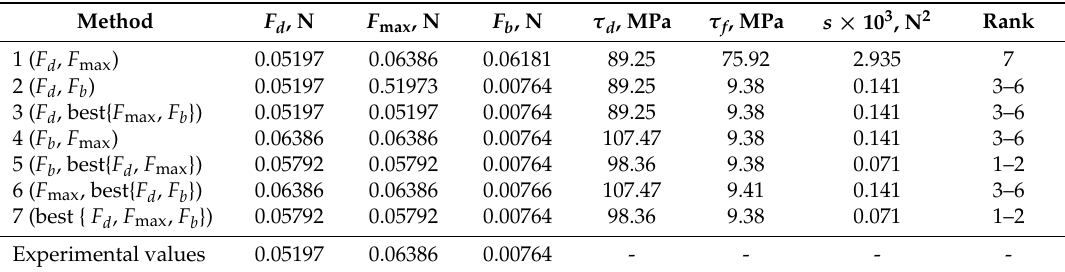
Table 6. Interfacial strength parameters determined from the experimental force–displacement curve for carbon fiber (CF2)–H135 epoxy matrix pair using different